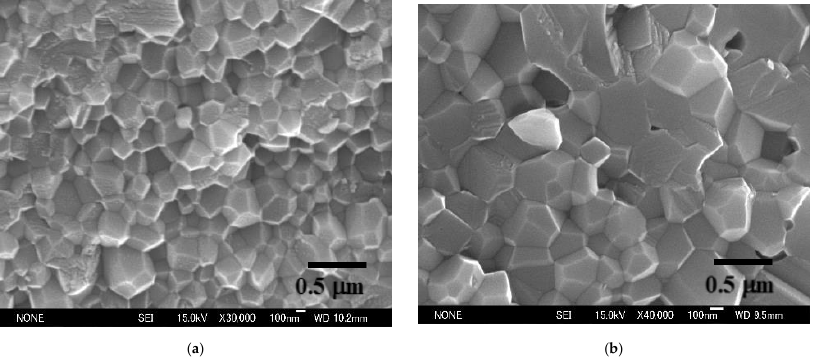
Figure 28. FE-SEM micrograph of α -Al 2 O 3 prepared at 1423/1473 K, under 30 and 100 MPa: ( a ) 100 MPa, 1423 K, 99.18% TD; ( b ) 30 MPa, 1473 K, 98.3%